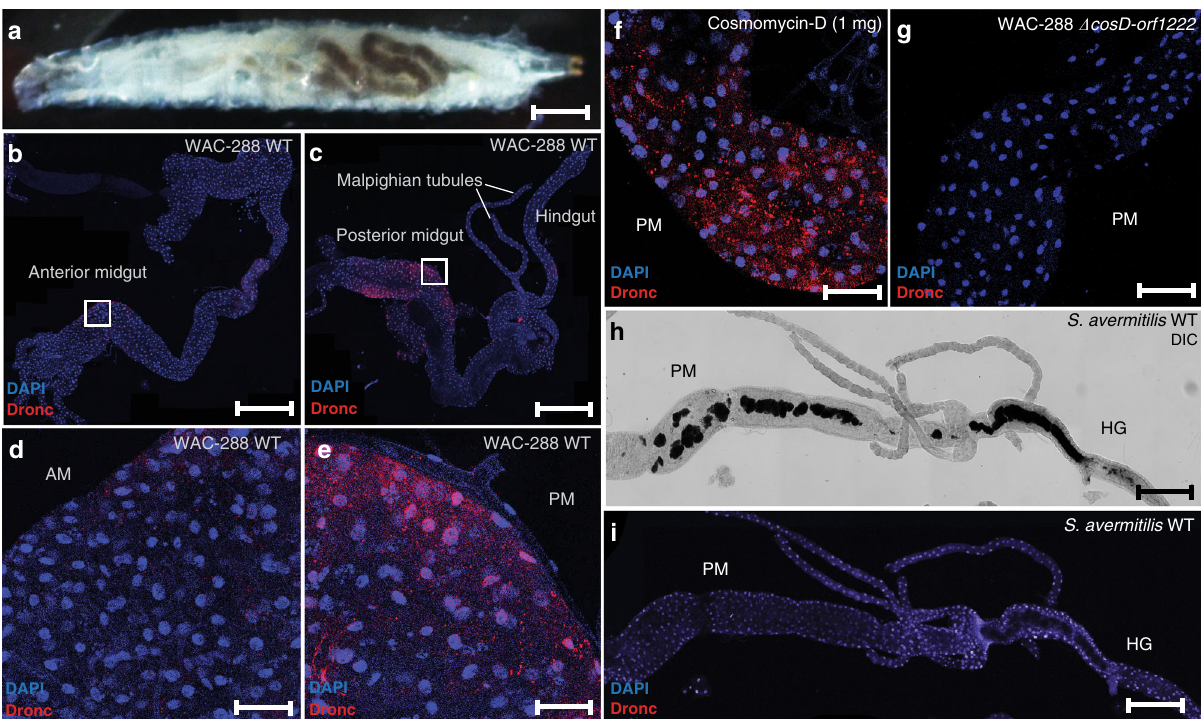
Fig. 3 Cell death in D. melanogaster is triggered by the consumption of cosmomycin D producing spores. a Third instar larvae that have fed on media containing spores of WAC-288. After feeding, larvae were dissected and processed for fl uorescence microscopy for the detection of activated Dronc which is the caspase-9 homolog in Drosophila (Scale bar = 1 mm) Speci fi c regions of the ( b ) anterior and ( c ) posterior/hindgut were identi fi ed and visualized (Scale bars = 1 mm). Images at a higher magni fi cation of the ( d ) anterior midgut shows lower levels of Dronc activation compared to the ( e ) posterior midgut which displays higher levels of activation (Scale bars = 50 µ m). f Activation of Dronc in posterior midgut of larvae that fed on food containing 1 mg of pure cosmomycin D isolated from WAC-288 (Scale bar = 1 mm). g No activation in the posterior midgut of larvae that were fed spores of the cosmomycin D de fi cient mutant Δ cosD-orf1222 (Scale bar = 1 mm). h Spores of S. avermitilis are visible and accumulate in the posterior midgut and hindgut (Scale bar = 1 mm). i Lack of Dronc activation within the indicated regions of larval guts that were fed S. avermitilis . Each result was individually reproduced three times with similar results (Scale bar = 1 mm).